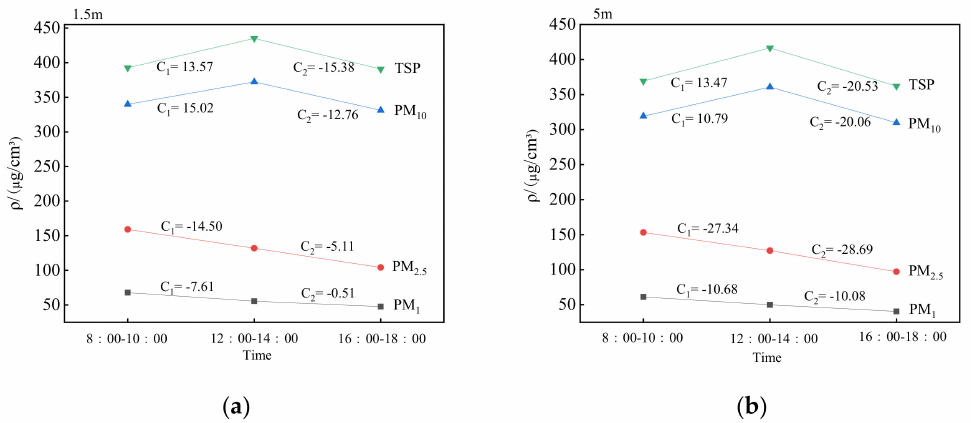
Figure 6. Influence of different time periods on airborne particulate matter at different heights. Note: C1 represents the generalized linear analysis coefficient of the change in airborne particulate matter concentration in the morning and noon. C2 represents the generalized linear analysis coefficient of the change in airborne particulate matter concentration in the noon and evening. The absolute value of C represents the difference between the factor level and the population mean. ( a ) Influence of different time periods on airborne particulate matter at 1.5m height; ( b ) Influence of different time periods on airborne particulate matter at 5m